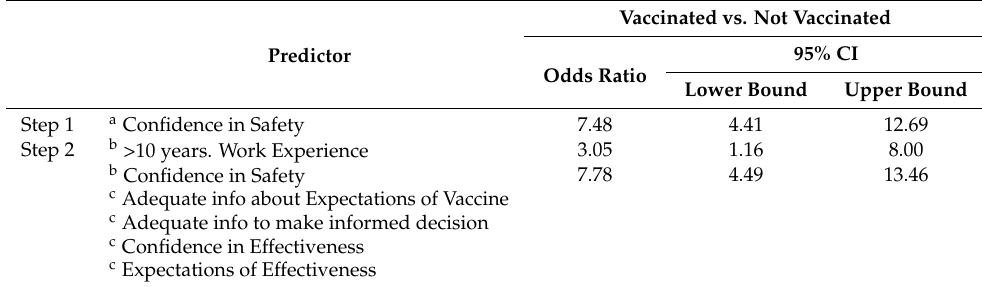
Table 4. Multivariate associations with COVID-19 vaccine uptake among nursing staff at a large medical center ( n =